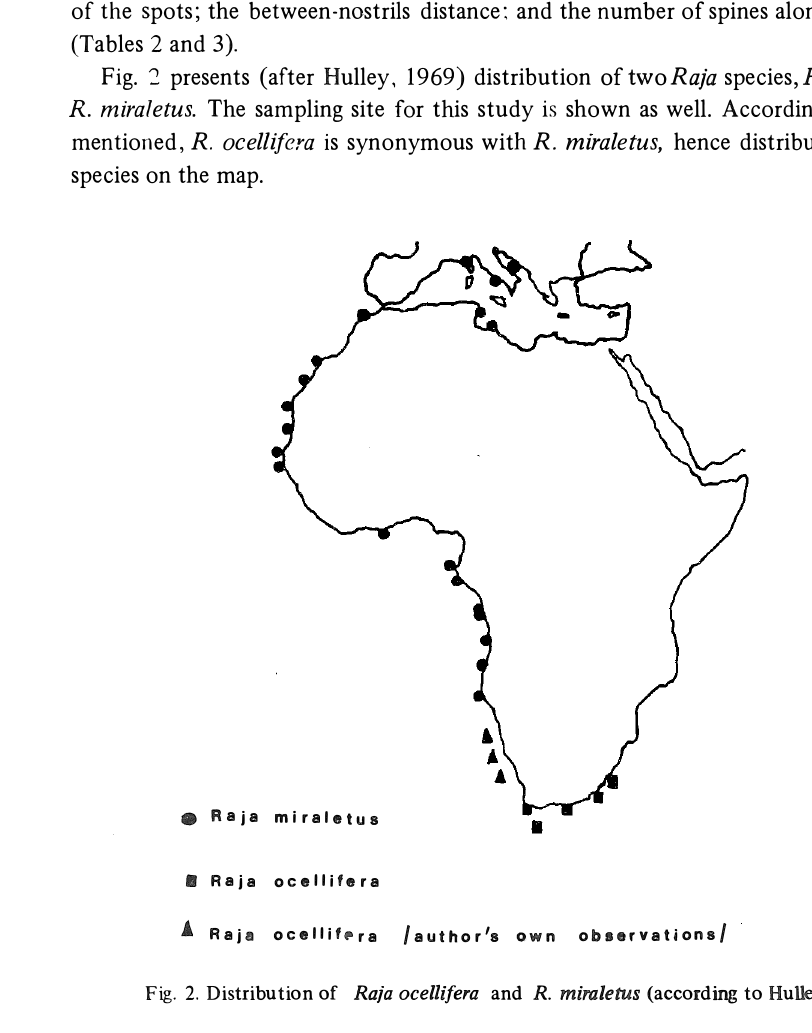
Fig. 2. Distribution of Raja ocellifera and R. miraletus (according to Hulley,